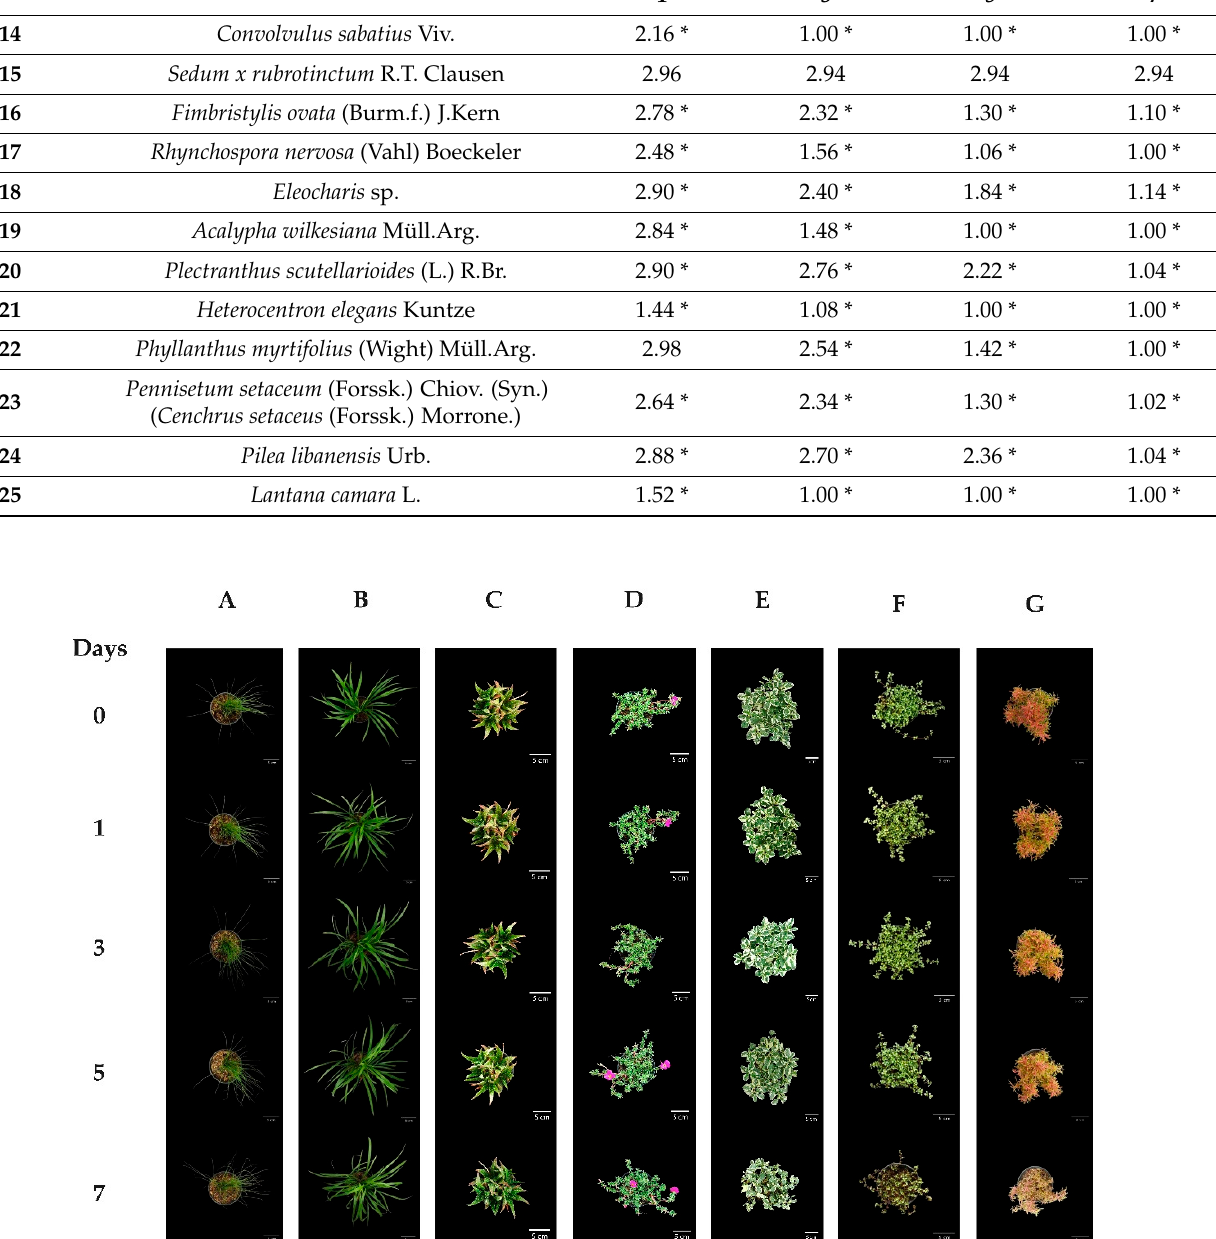
Figure A2. Images of plants under the drought treated conditions at 5 time intervals:0, 1, 3, 5, and 7 days after the start of the experiment ( Lantana camara : A, Heterocentron elegans : B, Hemigraphis alternata : C: Convolvulus sabitus : D, Dianella caerulea : E, Achillea millefolium.